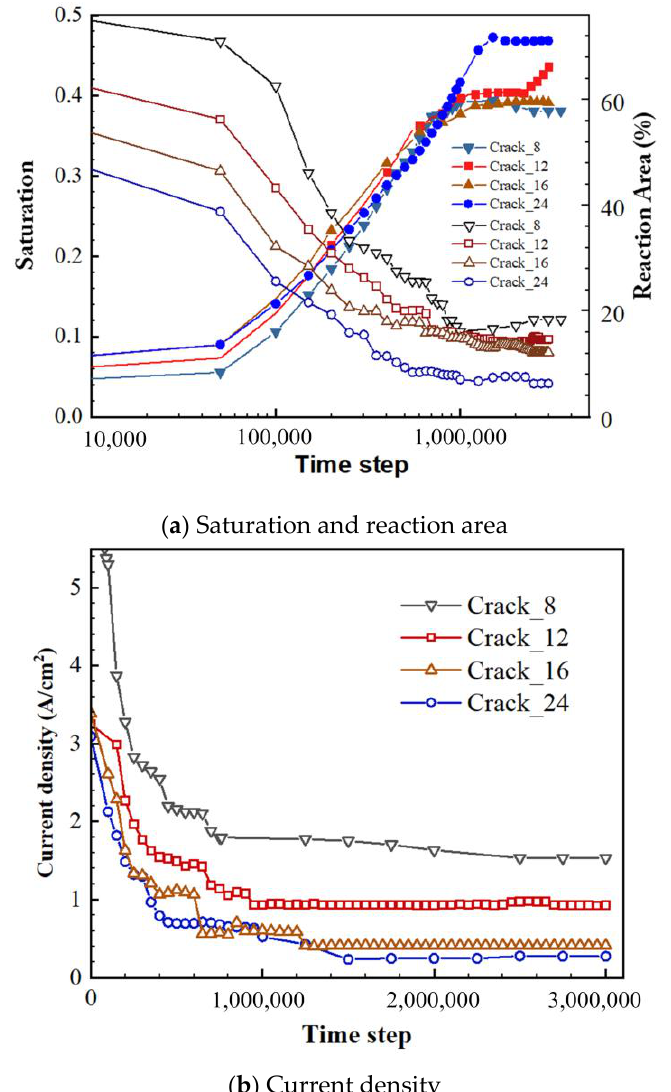
Figure 13. Time evolution of different variables: ( a ) saturation and reaction area and ( b ) current density.